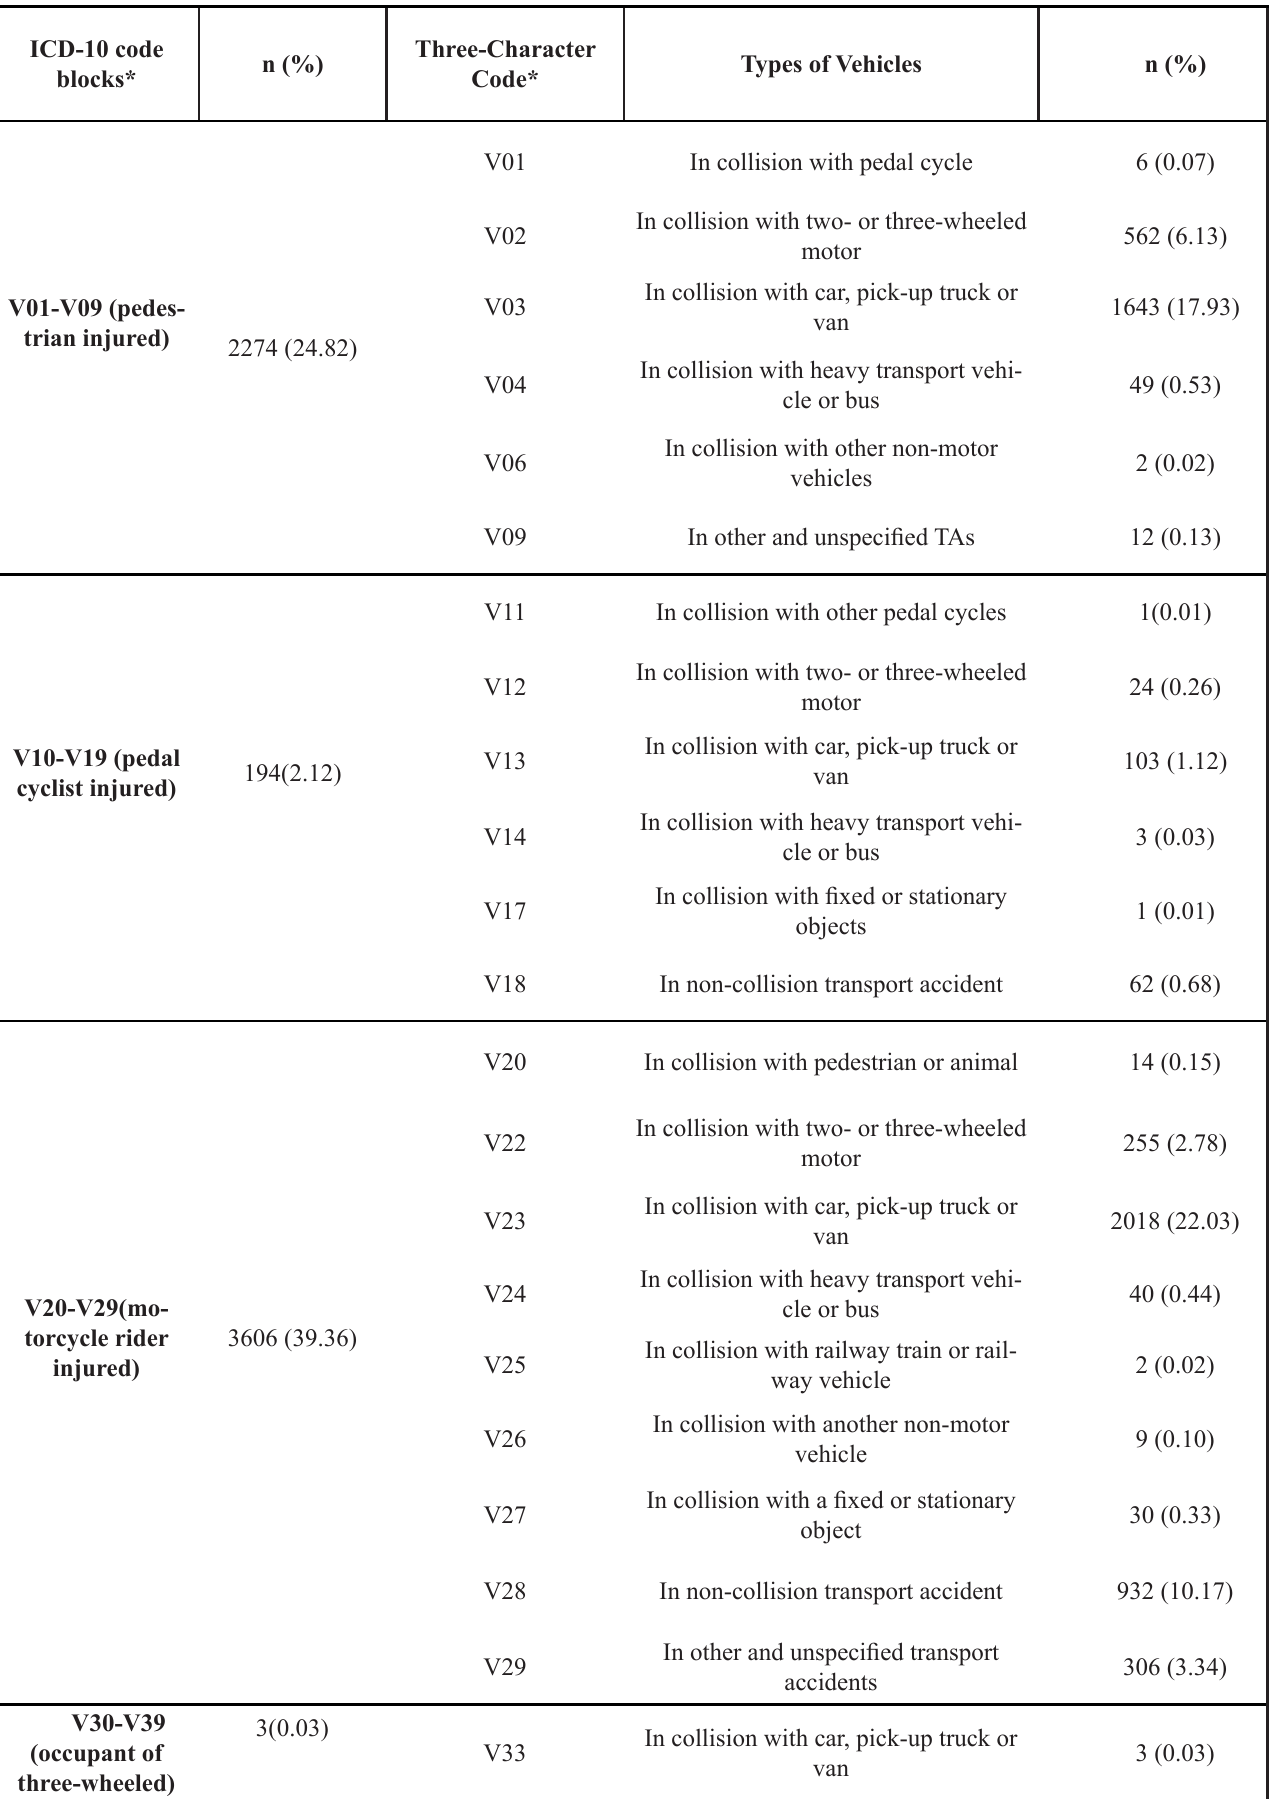
Table 2. The Number of Victims and Mode of Transport According to the Three-Character Level of ICD-10